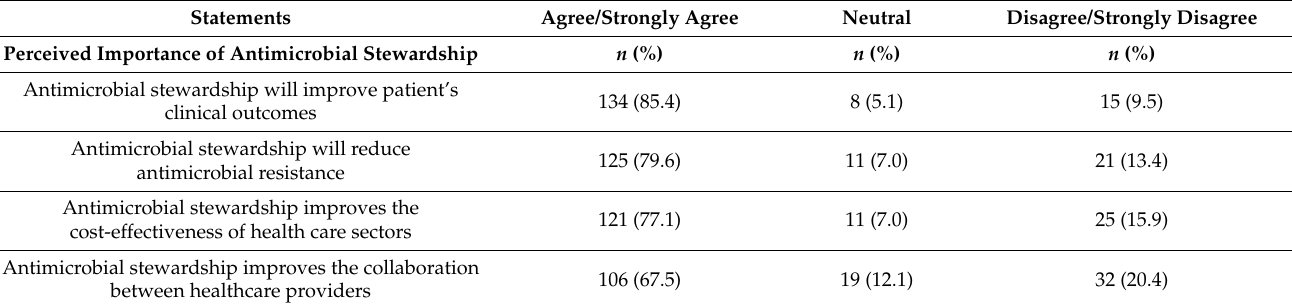
Figure 2. Available antimicrobial stewardship strategies at the hospitals as reported by the healthcare providers ( n = 157). Table 3. Assessment of healthcare providers’ perception towards the importance of antimicrobial stewardship programs ( n = 157).